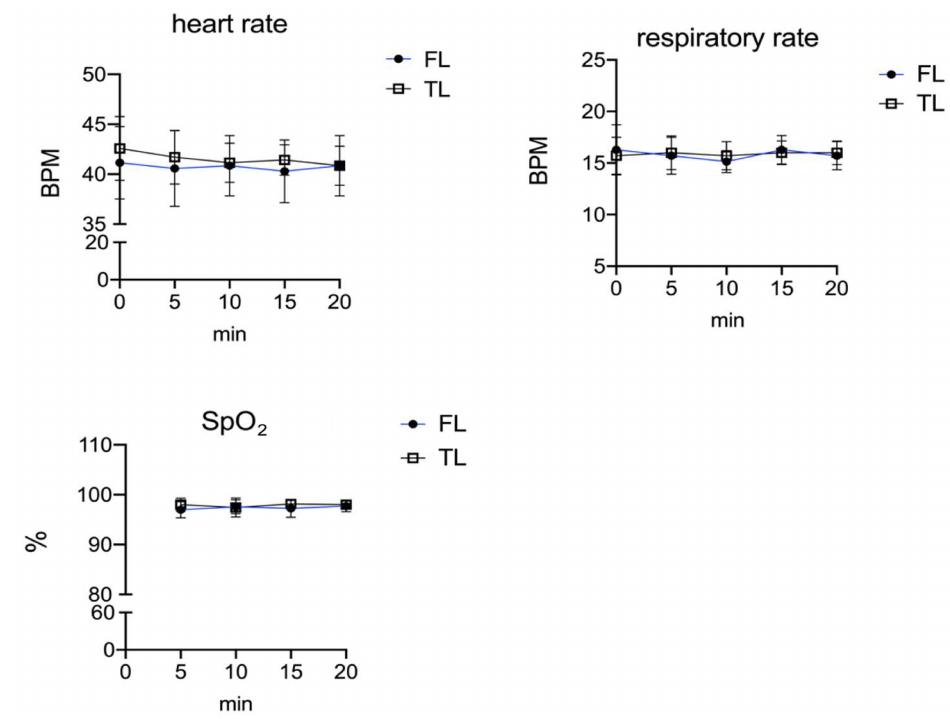
Figure 2. Timeline of heart rate (HR), respiratory rate (RR), and SpO 2 during anaesthesia and surgical procedures. All values are shown as the mean ± standard deviation (SD) of N observations (N = 8) for each group.